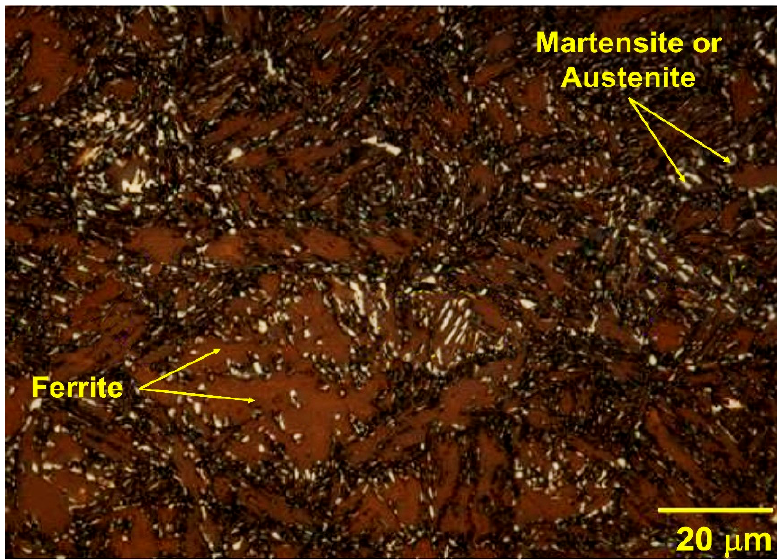
Figure 6. Optical micrography of M390-300 steel etched with Le Pera.